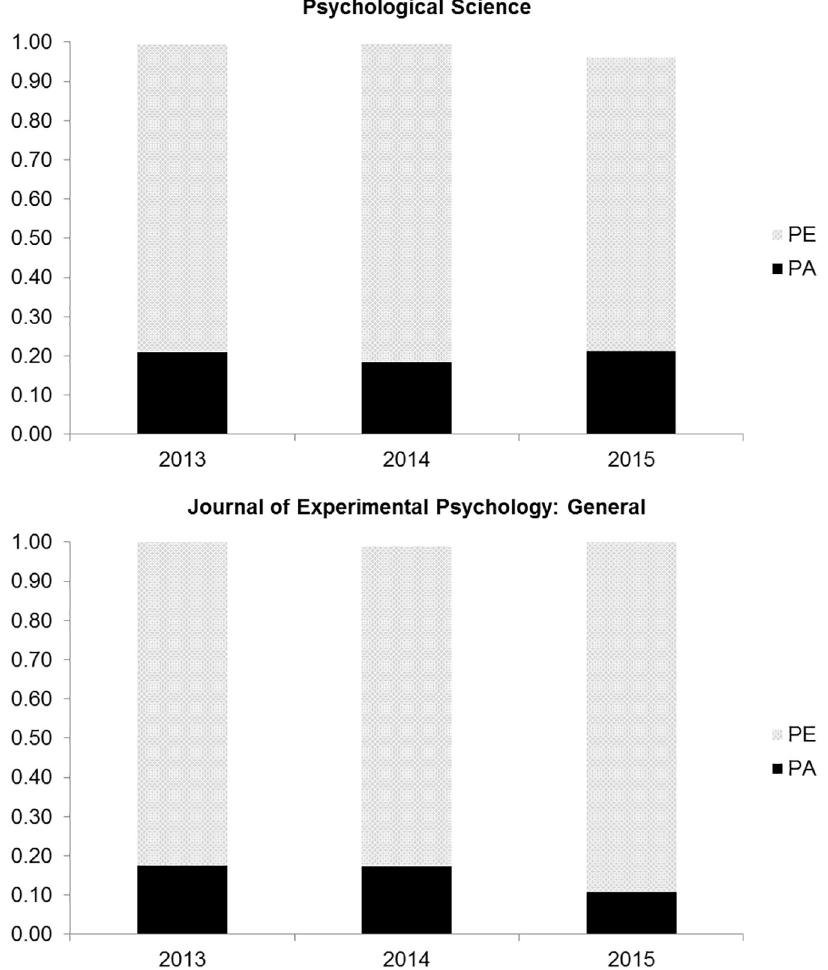
Fig 2. Proportions of papers with a PA (p relative) or a PE (p exact), in Psychological Science, and the Journal of Experimental Psychology: General from the 2013 to the